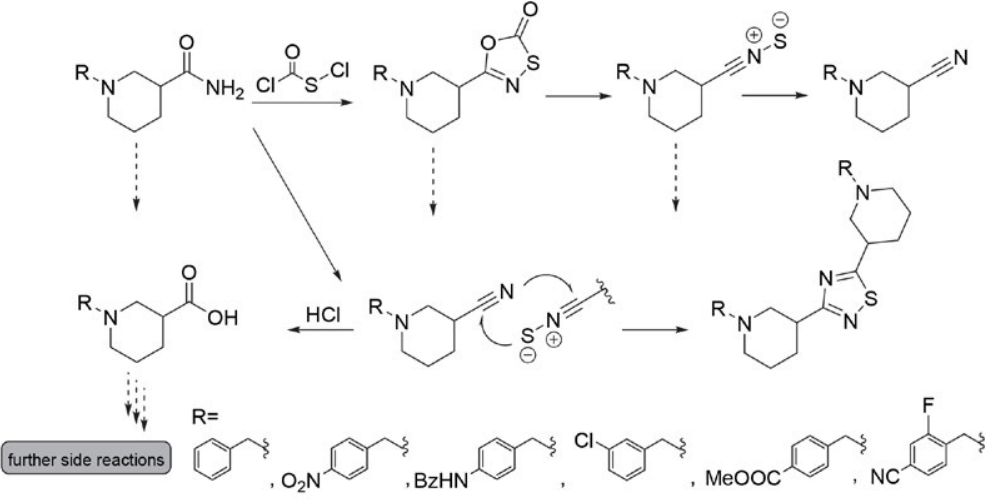
Figure 6. Possible side reaction pathways in the synthesis of piperidin-3-yl-oxathiazol-2-ones.